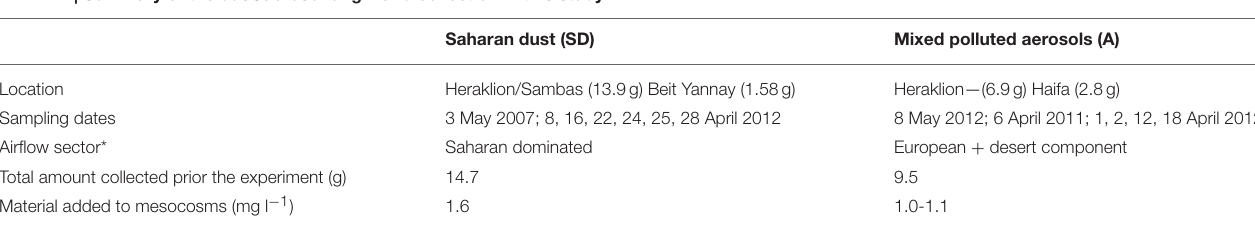
TABLE 1 | Summary of the dust/aerosol origin and collection in this study.